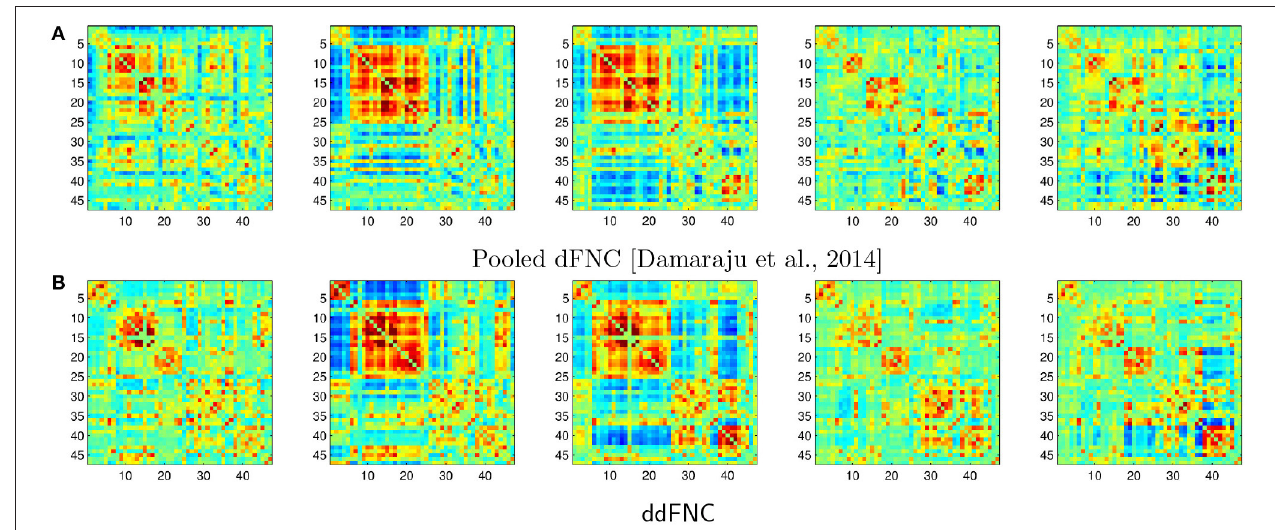
FIGURE 9 | The k = 5 centroids for pooled dFNC from Damaraju et al. (2014) (A) , and the hungarian-matched centroids from ddFNC (B)